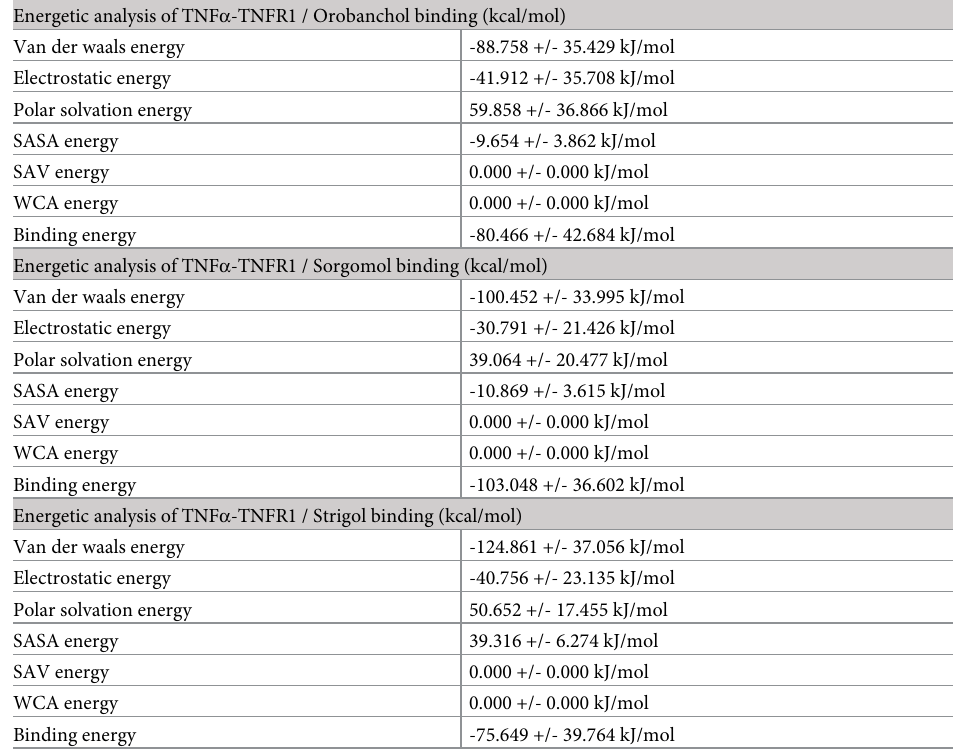
Table 3. Calculation of binding free energy between TNF α -TNFR1 with orobanchol, sorgomol and